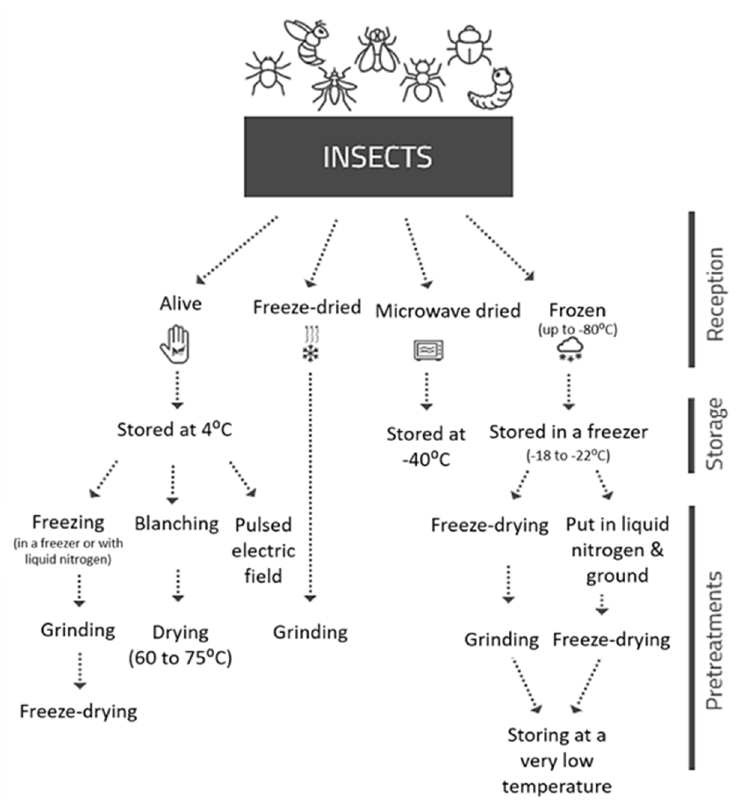
Figure 2. Different methods of reception, storage, and pretreatments of edible insects.